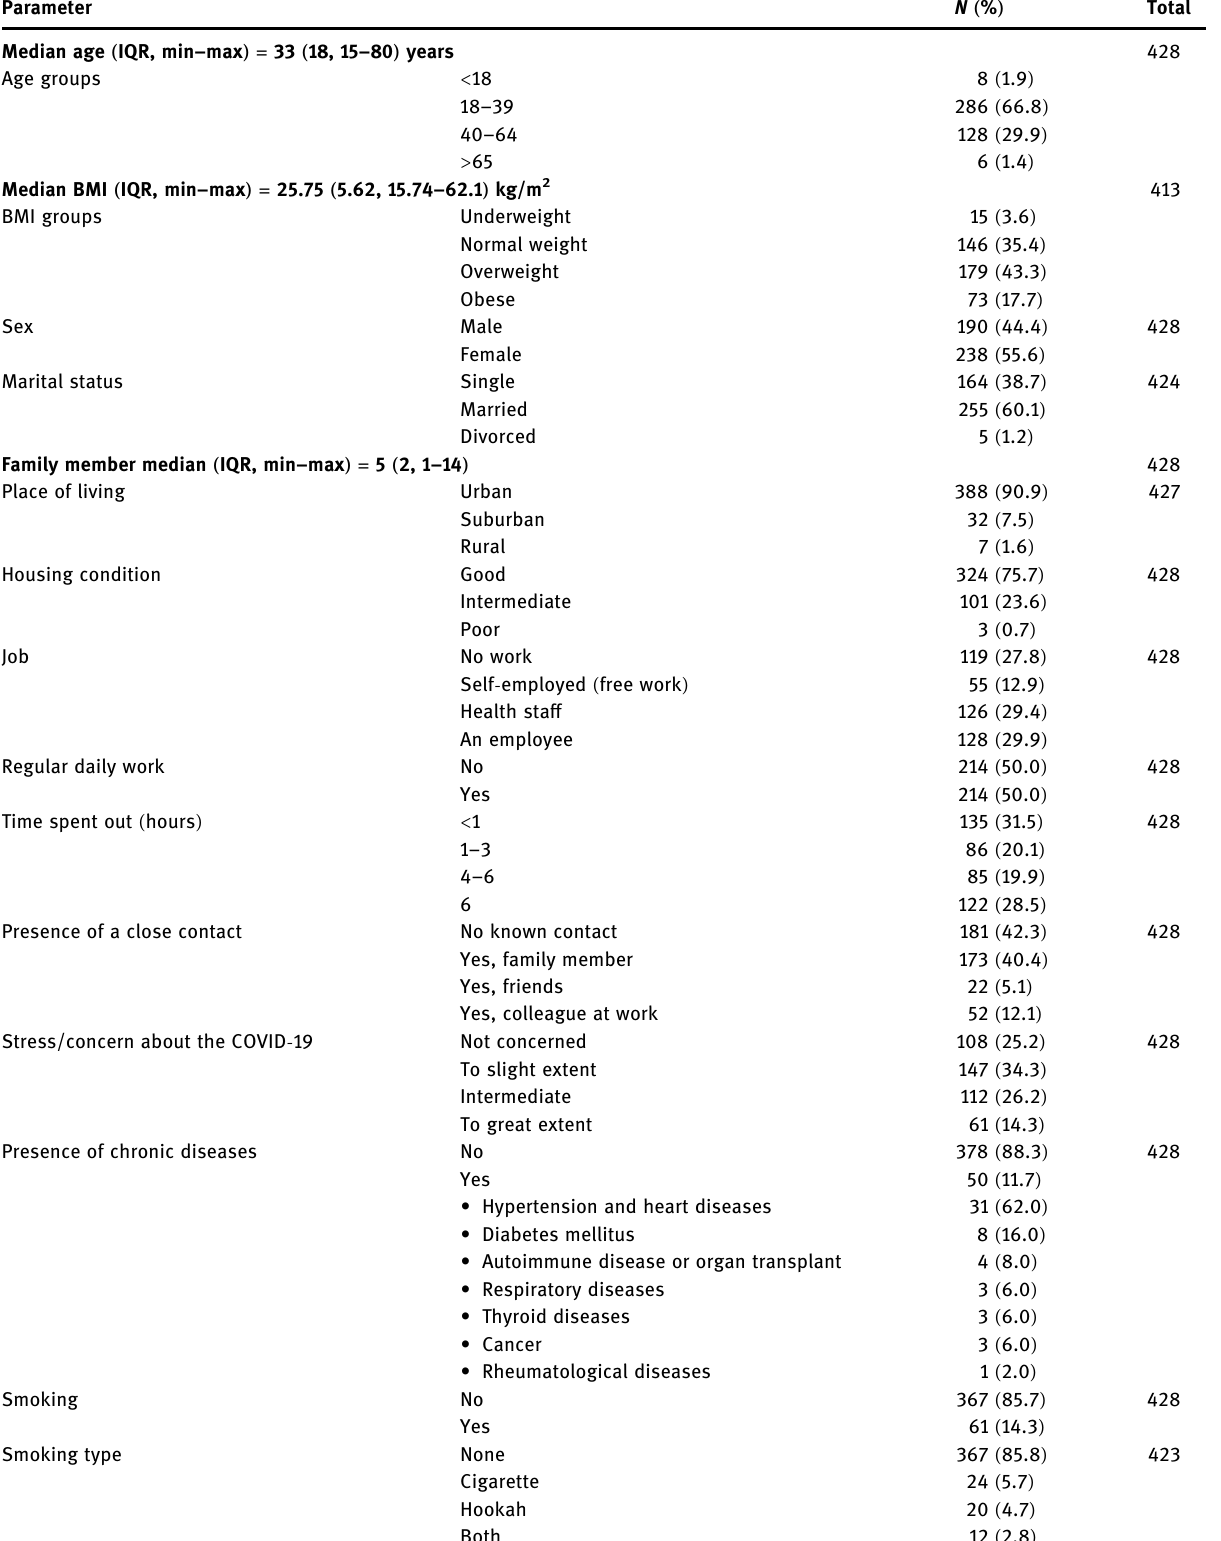
Table 1: General characteristics and socio - demographic parameters of the studied participants